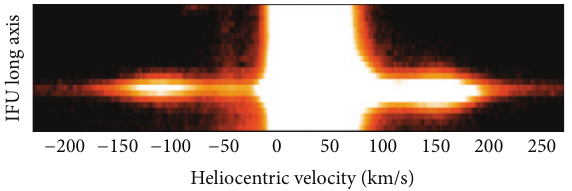
Figure 3: Image adapted from [51] showing the H 𝛼 emission profile of the LV2 proplyd observed with FLAMES with an effective velocity resolution of about 2.3 kms −1 pixel −1 (FWHM velocity resolution of 7.7 kms −1 ). The red- and blue-shifted components of the bipolar jet are clearly resolved, even without subtracting the bright background emission of the nebula. The intensity scale is logarithmic with a minimum of 5.4 × 10 −17 (black) and a maximum of 1.1 × 10 −13 ergs −1 cm −2 (white). The length of the vertical axis is 6.6 󸀠󸀠